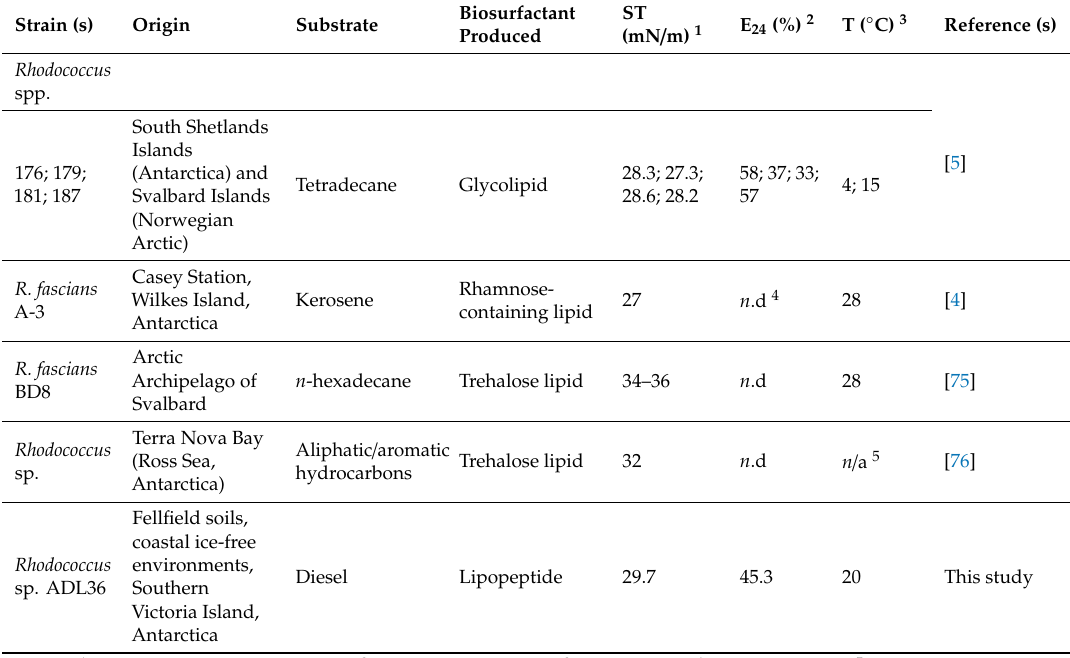
Biosurfactant ST E 24 (%) 2 T ( ◦ C) 3 Reference (s) Produced (mN / m) 1